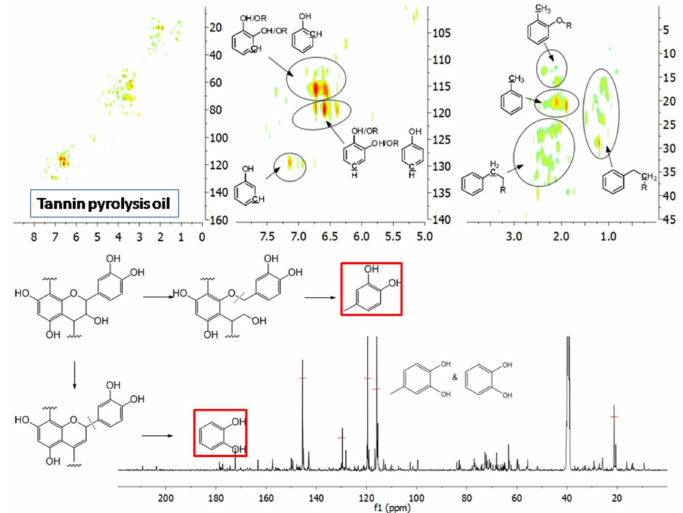
Figure 3. Major pyrolysis products produced from tannin and possible